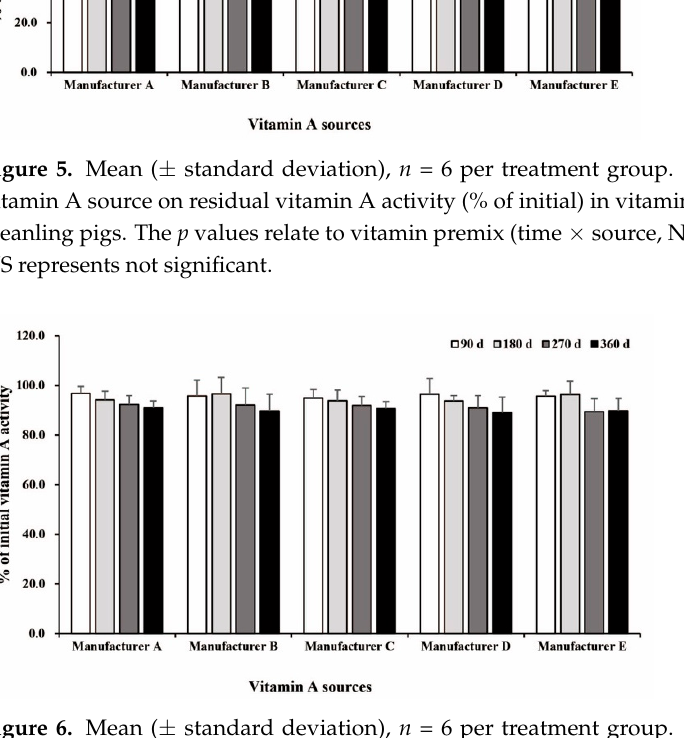
Figure 6. Mean ( ± standard deviation), n = 6 per treatment group. Effects of storage time and vitamin A source on residual vitamin A activity (% of initial) in vitamin-trace mineral premixes for finishing pigs. The p values relate to vitamin premix (time × source, NS; time, p < 0.01; source, NS). NS represents not